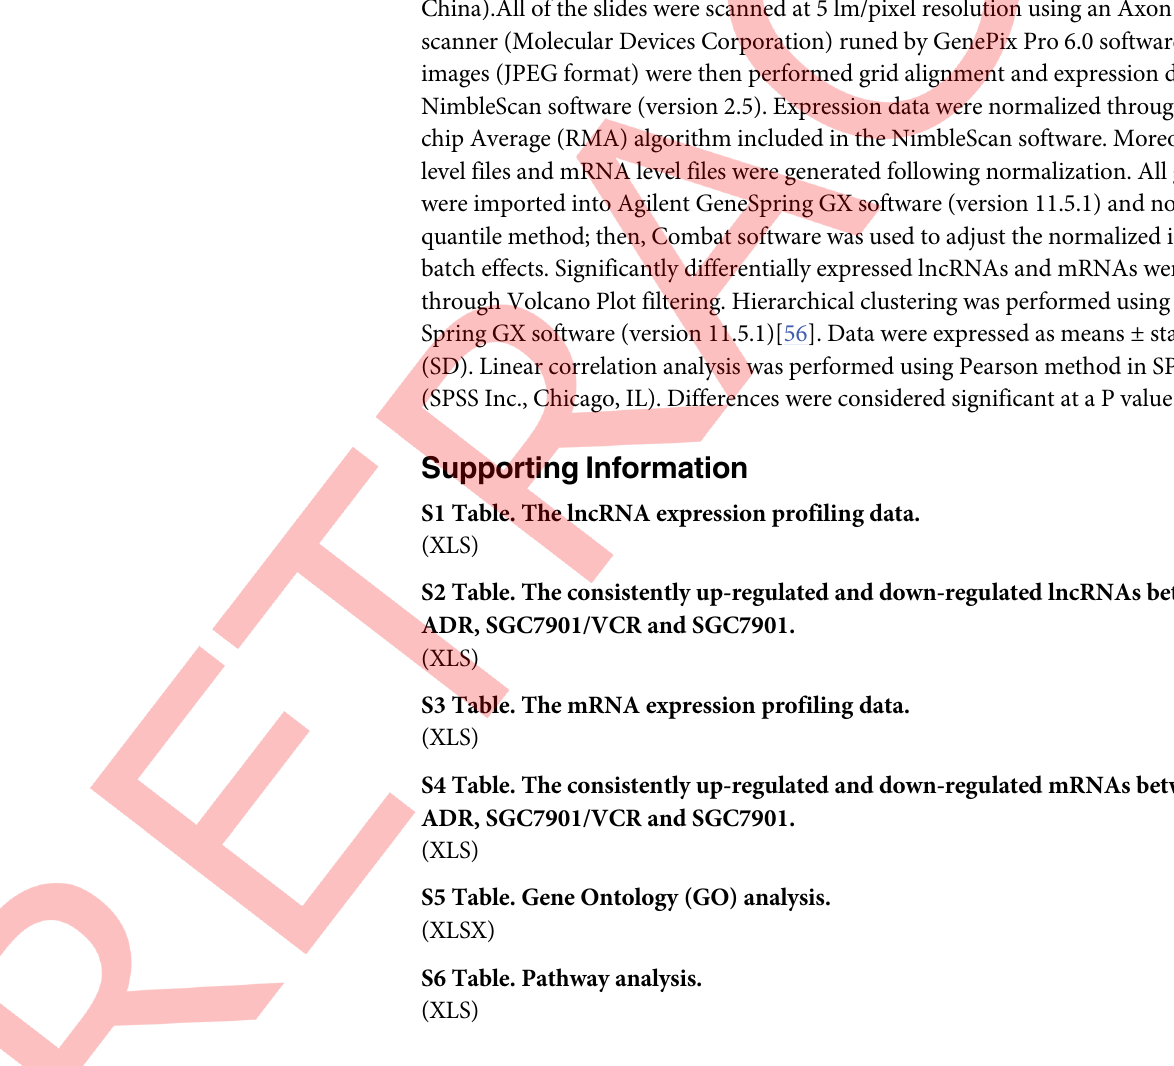
S6 Table. Pathway analysis.